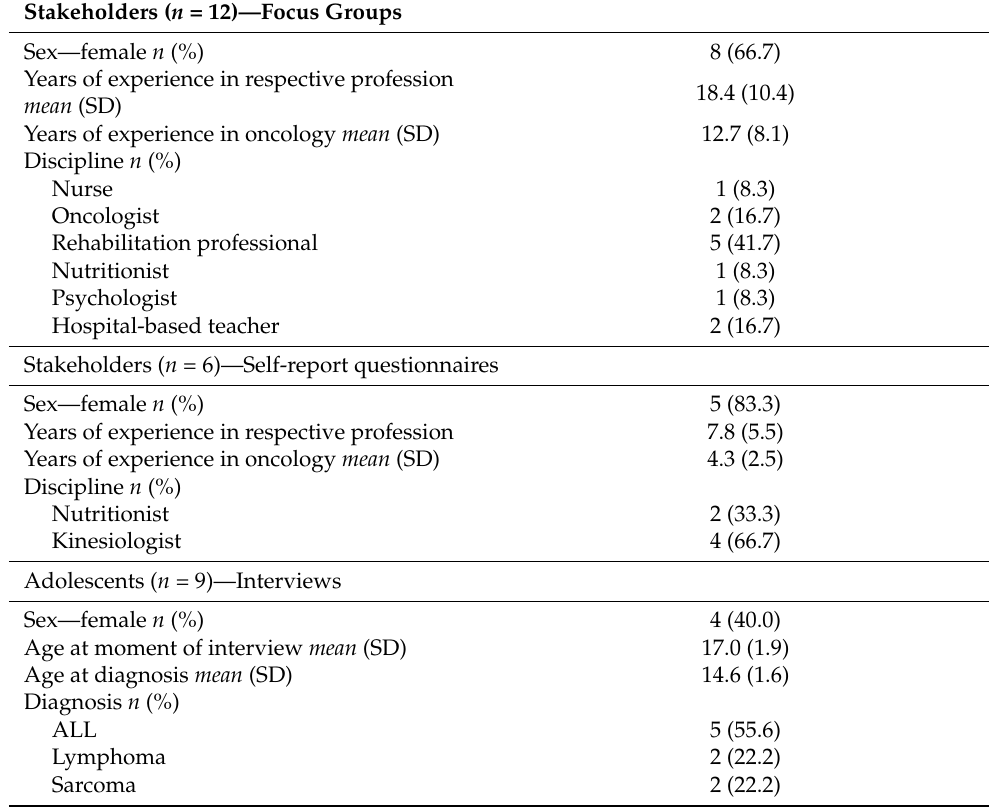
Table 1. Demographic characteristics of